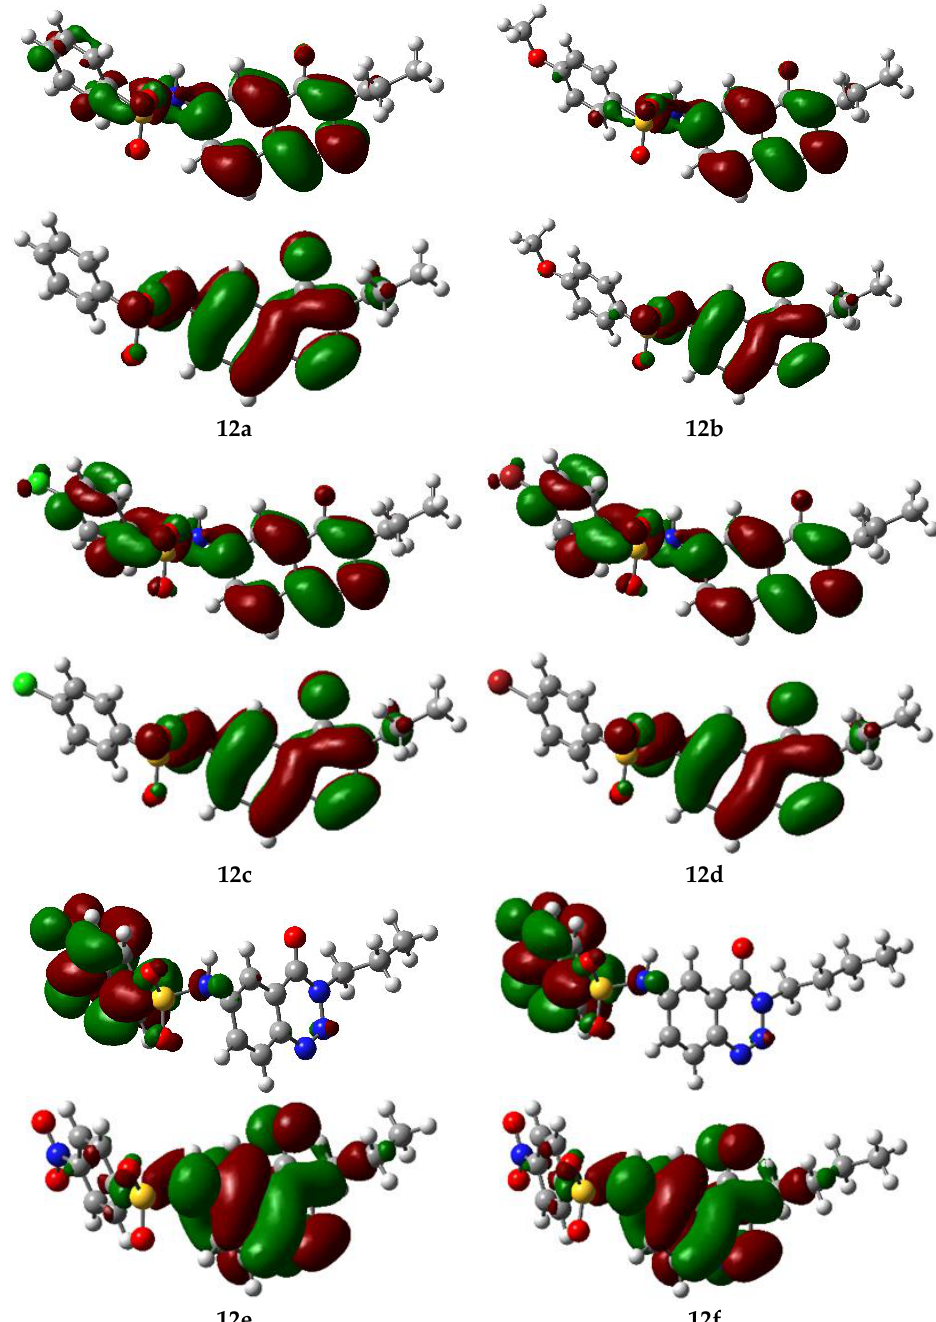
Figure 5. Pictorial illustration of charge density distribution in molecular orbitals of compounds 12a – 12f . HOMO is shown at the bottom and LUMO is displayed at the